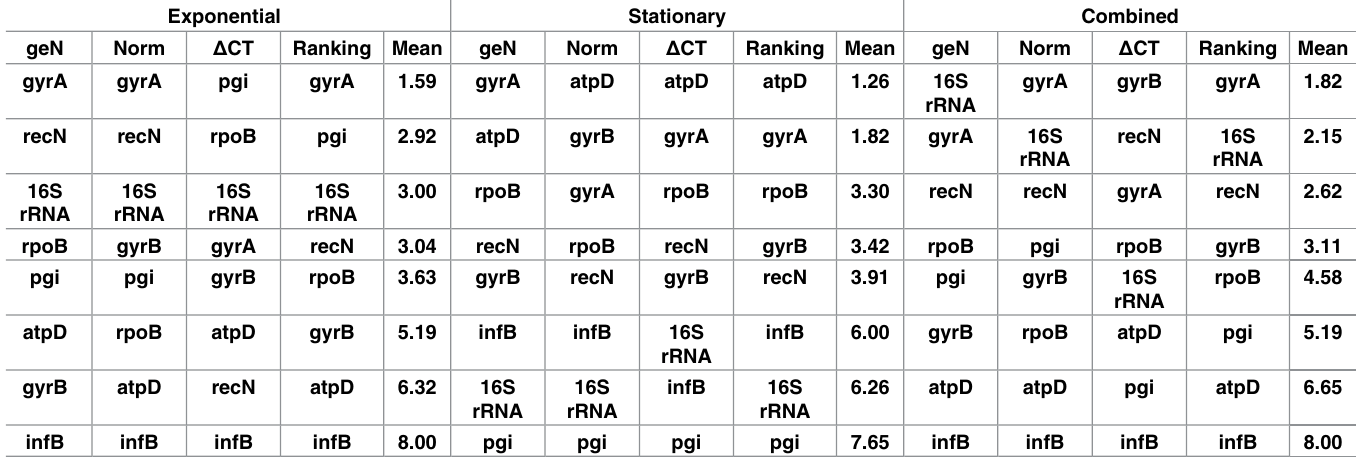
Table 9. Candidate referencegenes ranked by different methods in